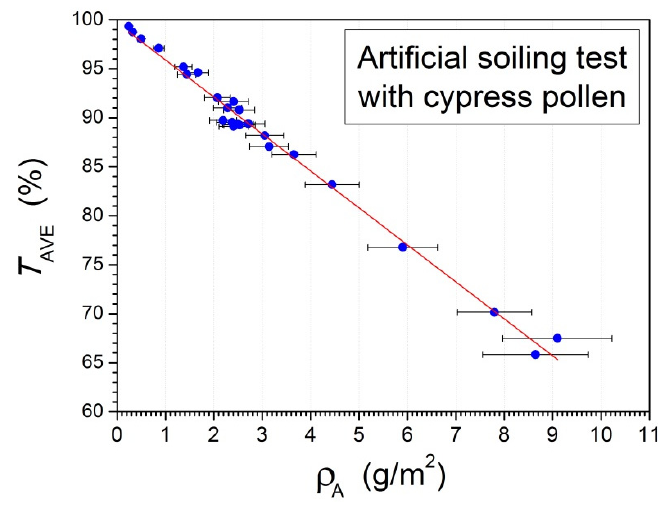
Figure 12. Linear fitting of the averaged transmittance ( T AVE ) as a function of the pollen mass density ( ρ A